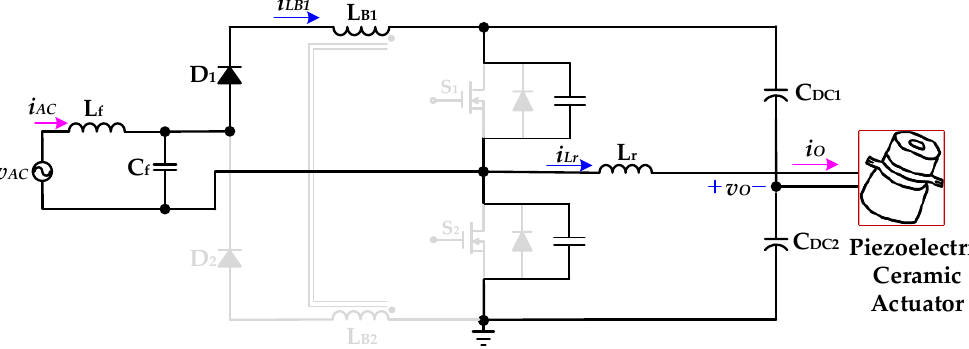
Figure 7. Operation Mode 2 of the proposed drive circuit for the piezoelectric ceramic actuator.